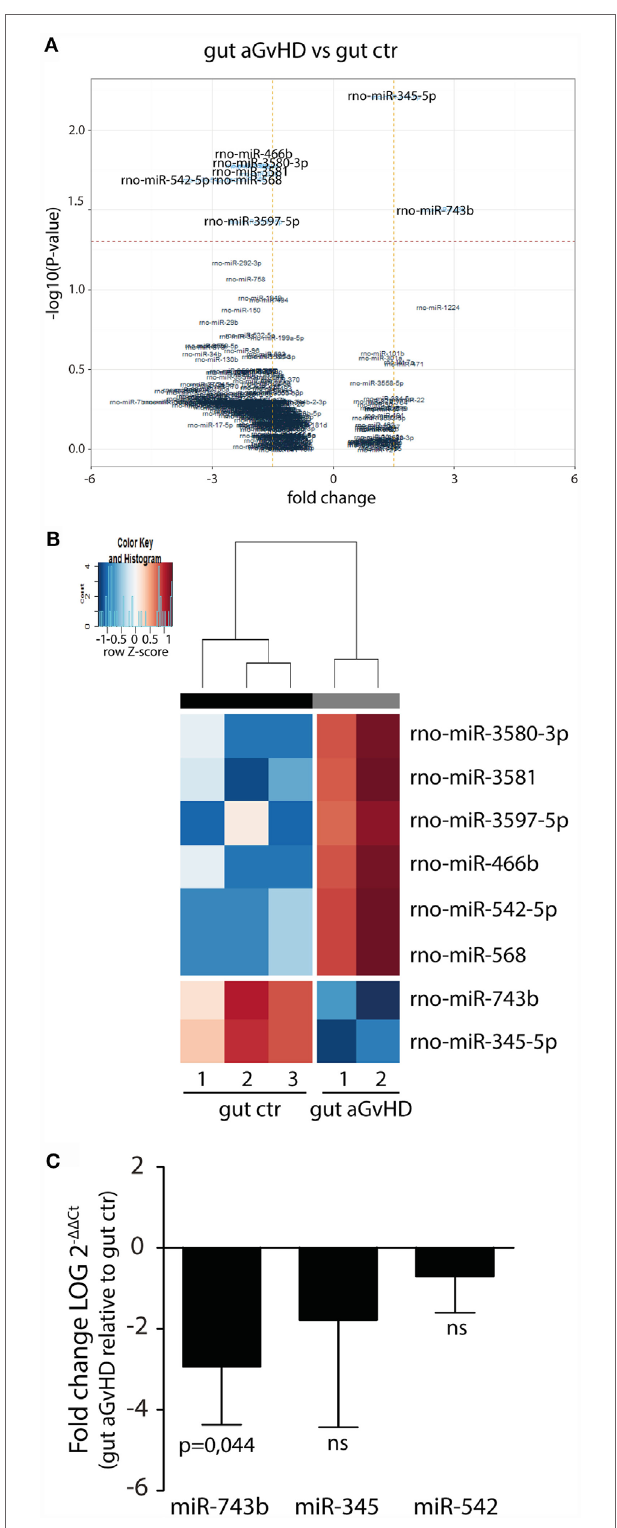
FigUre 5 | mirna expression signature in small intestines during agvhD .